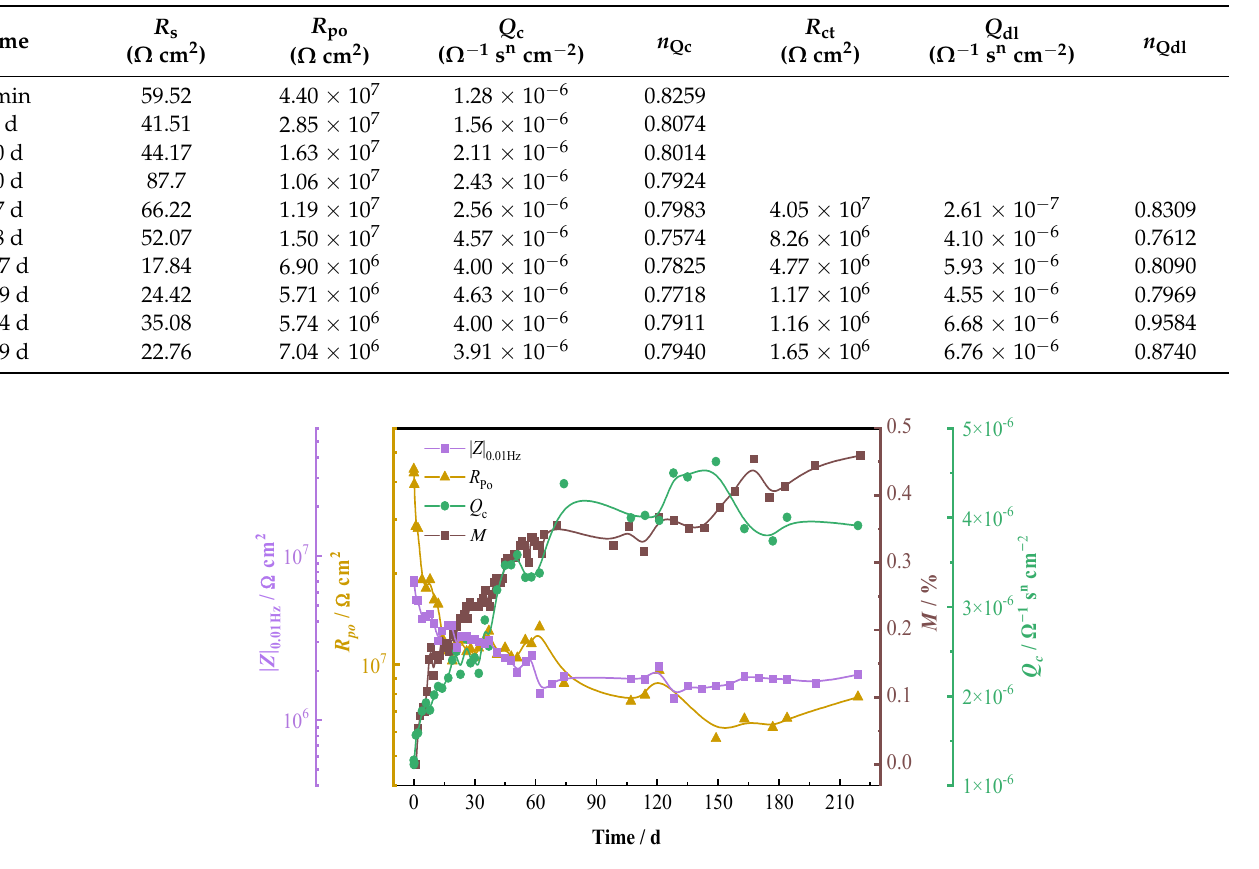
Figure 9. Variations of the percentage mass change, resin capacitance and resistance, and low-frequency impedance of T700/ BMI specimen with time.